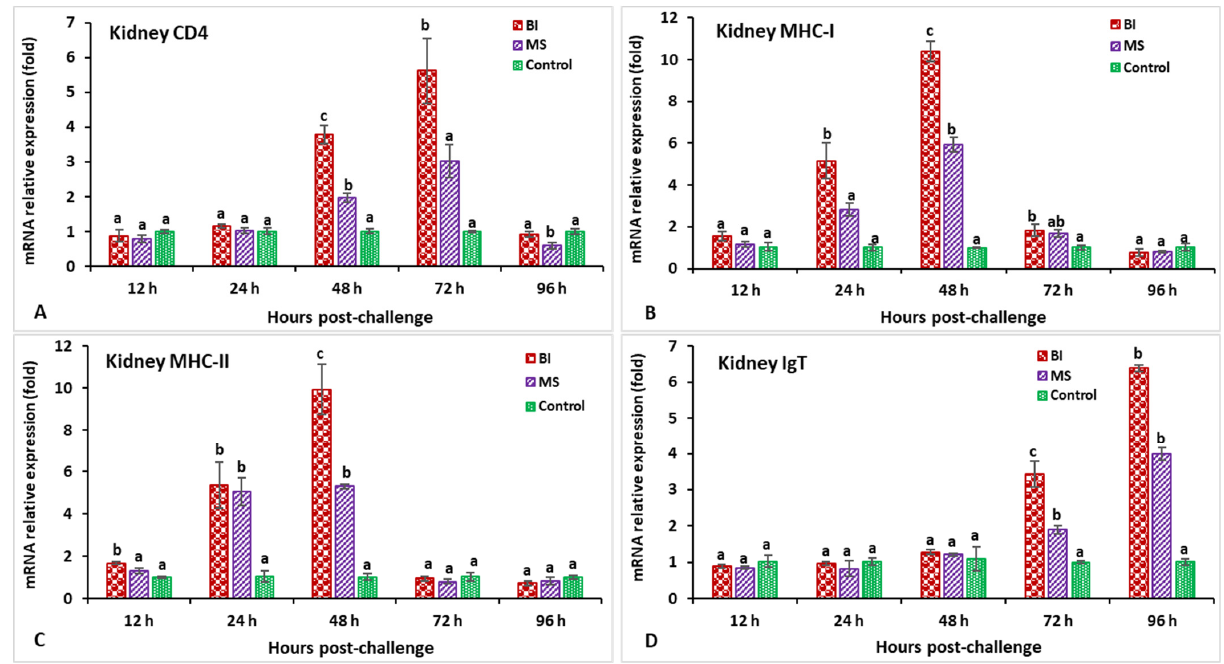
Figure 6. The gene expression of CD4 ( A ), MHC-I ( B ), MHC-II ( C ), and IgT ( D ) in the head kidneys of orally vaccinated fish after being challenged by Streptococcus iniae (mean ± SE, n = 3). Dissimilar letters denote significant differences ( p < 0.05).